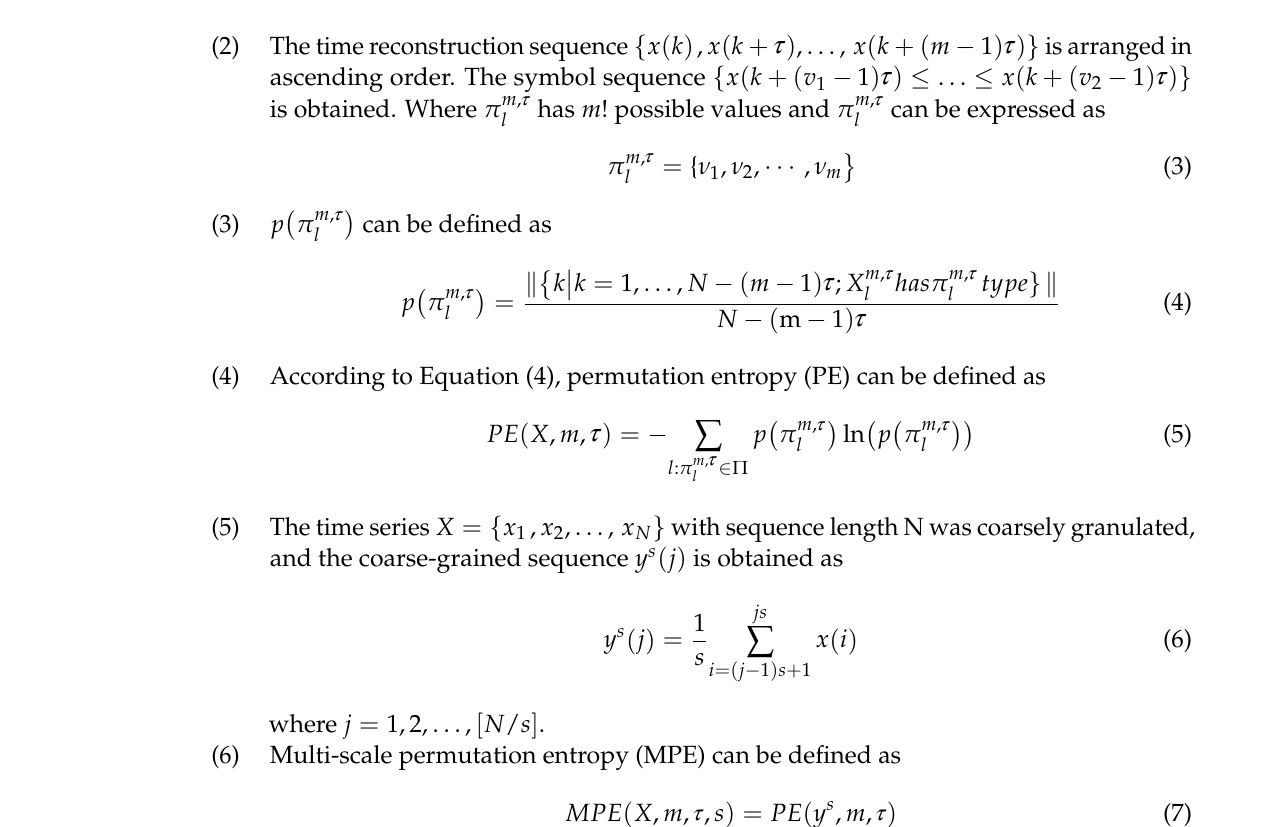
Figure 1. The traditional coarse-grained process with the scale factor 3 = s .